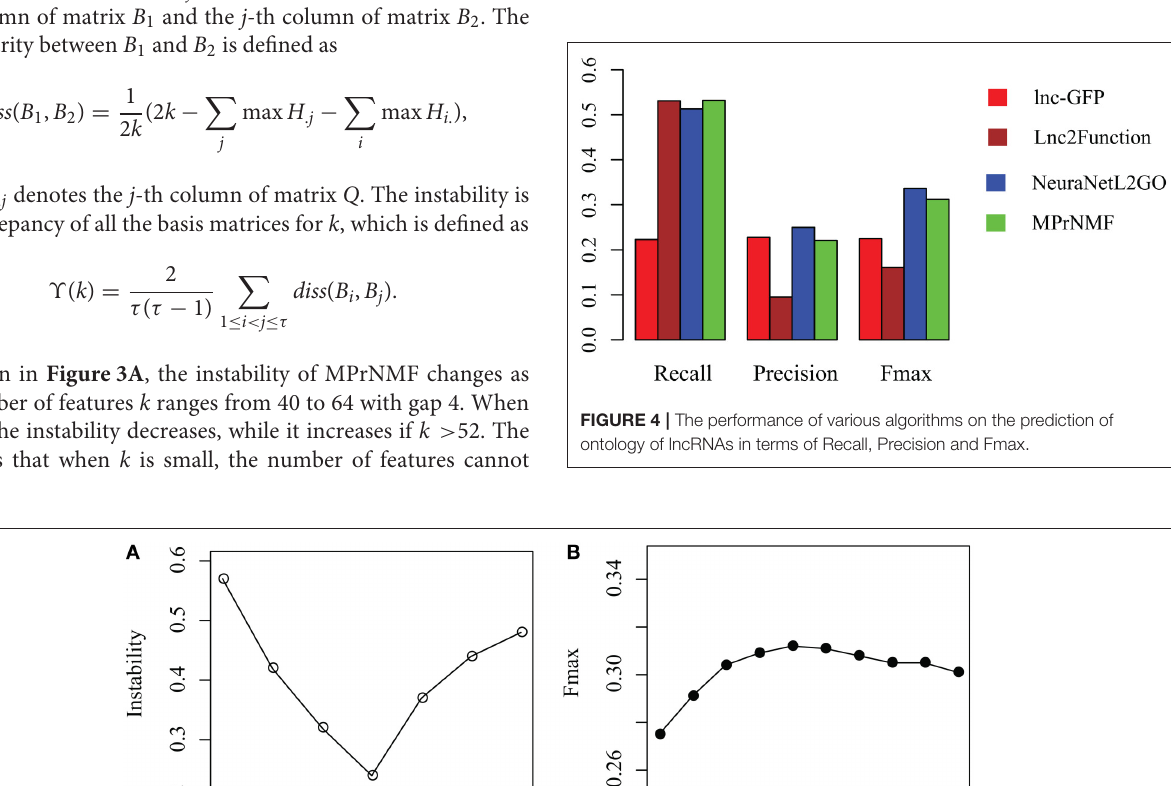
Frontiers in Genetics |